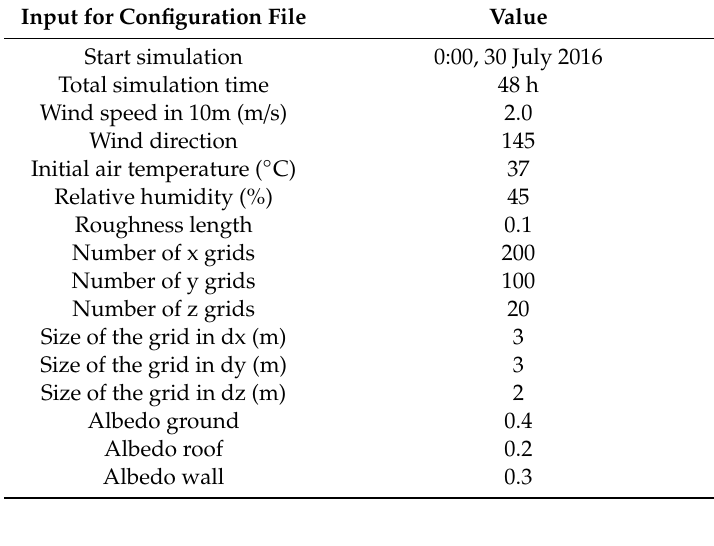
Table 5. Initial simulated data for ENVI-met.